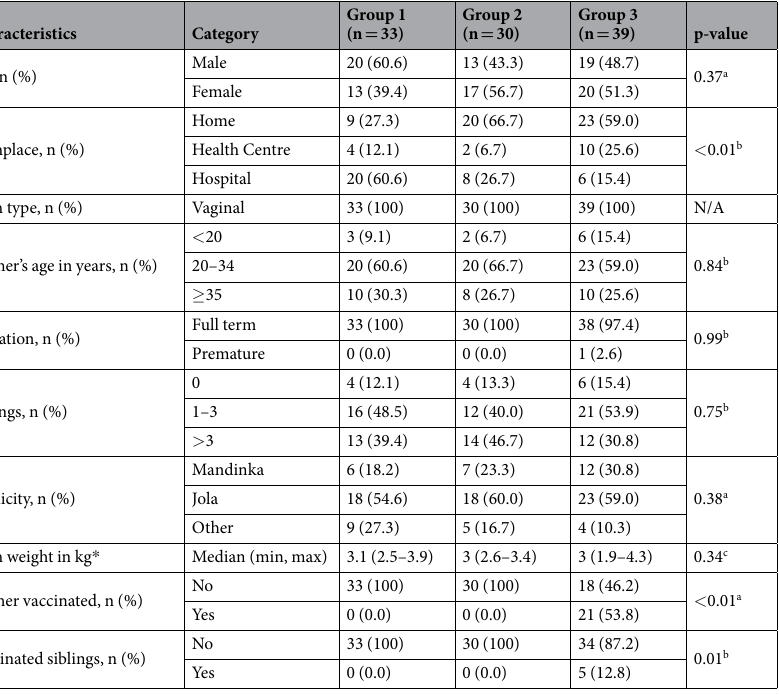
Table 1. Baseline characteristics of newborns and their mothers by study group. a Chi square test. b Fisher’s exact test. c Kruskal-Wallis test. * Birth weight was not recorded for 15, 16 and 11 of Group 1, 2 and 3 newborns